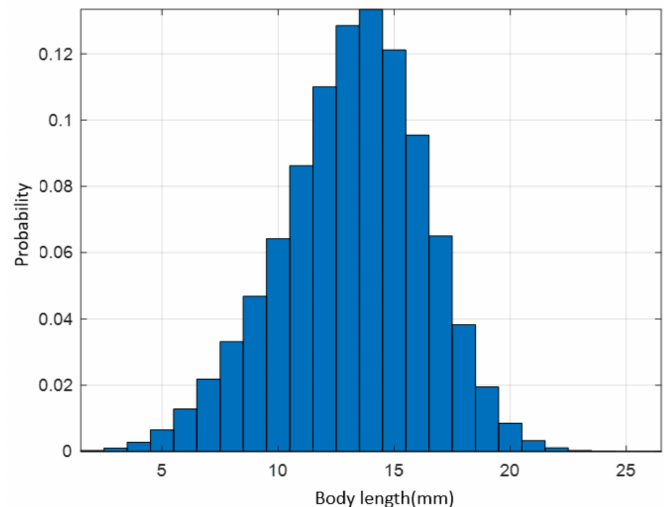
Figure 9. Probability model of insect body-length